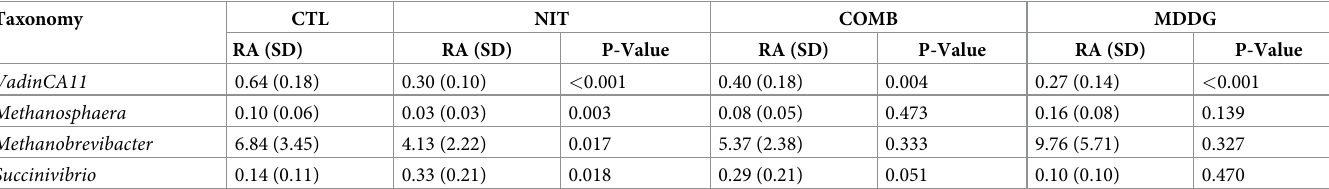
Table 3. Mean relative abundance (standard deviation) as a fraction of total prokaryotic reads for each additive treatment (NIT, MDDG and COMB) and signifi- cance of genera associated with methane emissions for each diet group relative to the CTL diet. P-Value corrected using Benjamini-Hochberg FDR. Taxonomy CTL NIT COMB MDDG RA (SD) RA (SD) P-Value RA